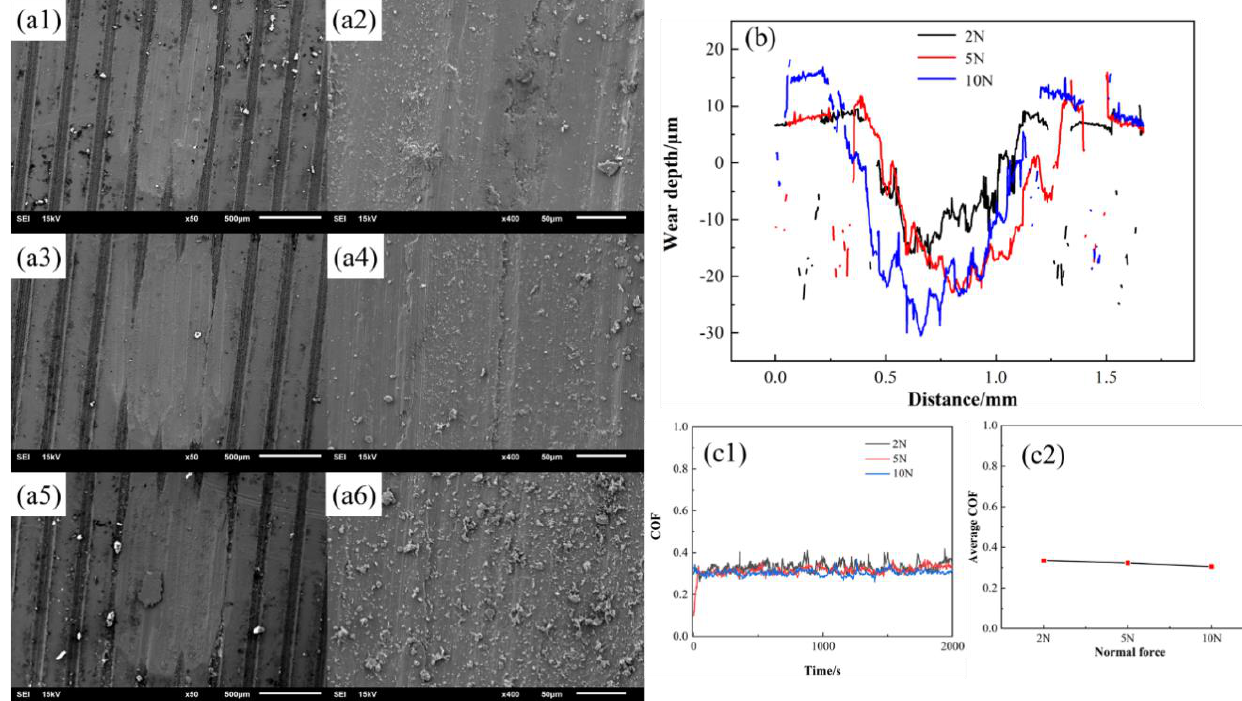
Figure 15. Morphology of Fe-Zn samples ( a1 ) T0.3-W0.1-C0.3-2N, ( a2 ) Enlarged view of a1, ( a3 ) T0.3-W0.1-C0.3-5N, ( a4 ) Enlarged view of a3, ( a5 ) T0.3-W0.1-C0.3-10N, ( a6 ) Enlarged view of a5; ( b1 , b2 ) Coefficient of friction of samples.